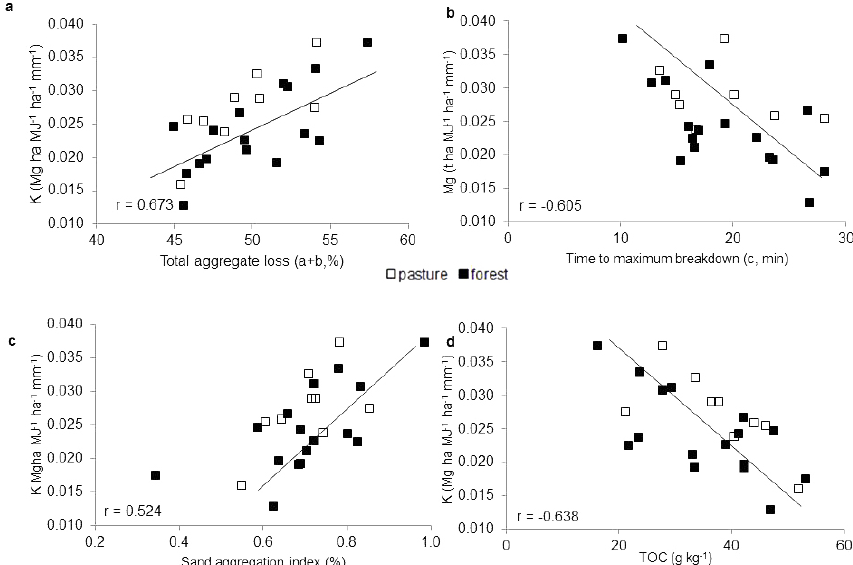
Figure 3. Correlations between K and aggregation stability parameters: (a) total loss of aggregates a + b ; (b) time to maximum breakdown, c ; (c) sand aggregation index; (d) organic carbon content (TOC). Black squares correspond to forest, open squares to pasture. All correlations had p< 0 . 01.